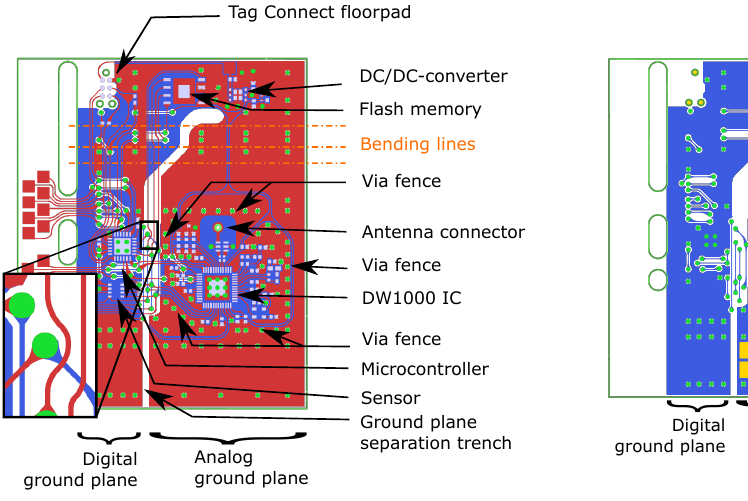
( a ) Top plane (red) and ground plane (blue). Some horizontal bending lines are highlighted in orange. surface plating (yellow). Figure 3. Layout of the Printed Circuit Board (PCB), top view.